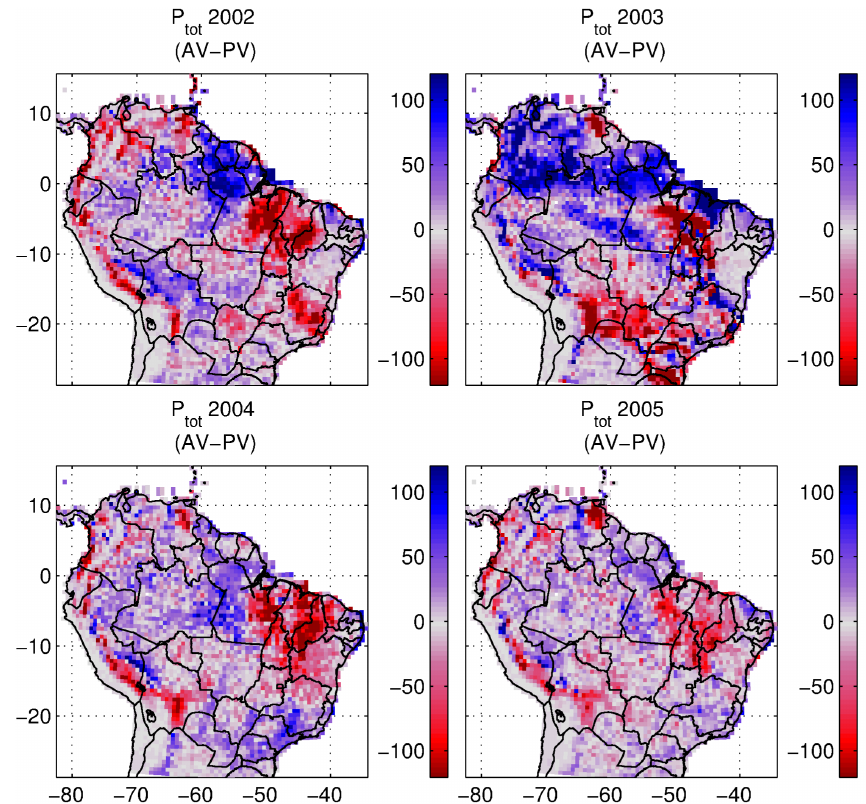
Figure 3. Differences in total annual surface precipitation (mm), 2002–2005. The potential vegetation (PV) condition is subtracted from the actual vegetation (AV) condition,